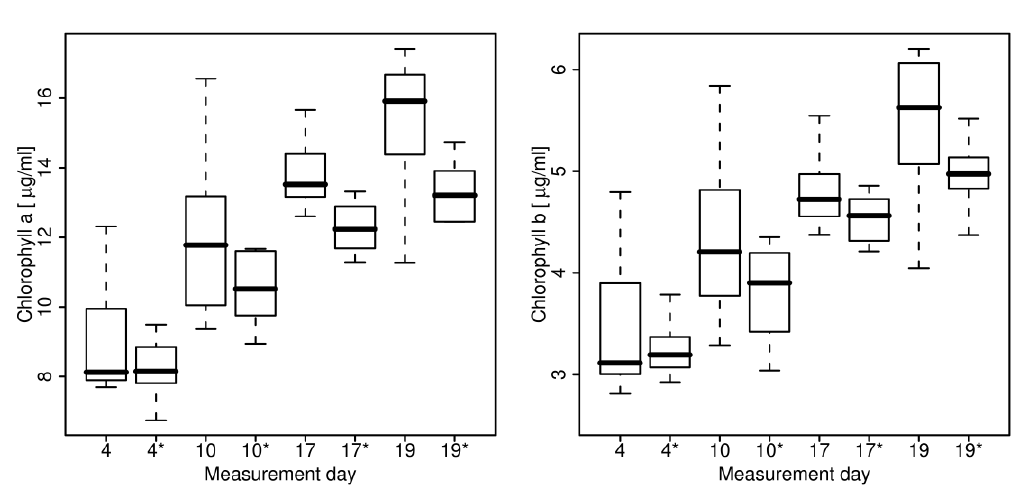
Figure 6. Boxplots depicting the outcomes of the destructive pigment extraction on different measurement days. Measurement days indicated with * represent results of scab inoculated leaves and without * the control